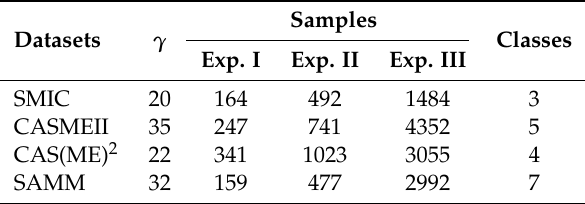
Table 5. Number of Total Samples Extracted for Experiment I, II and